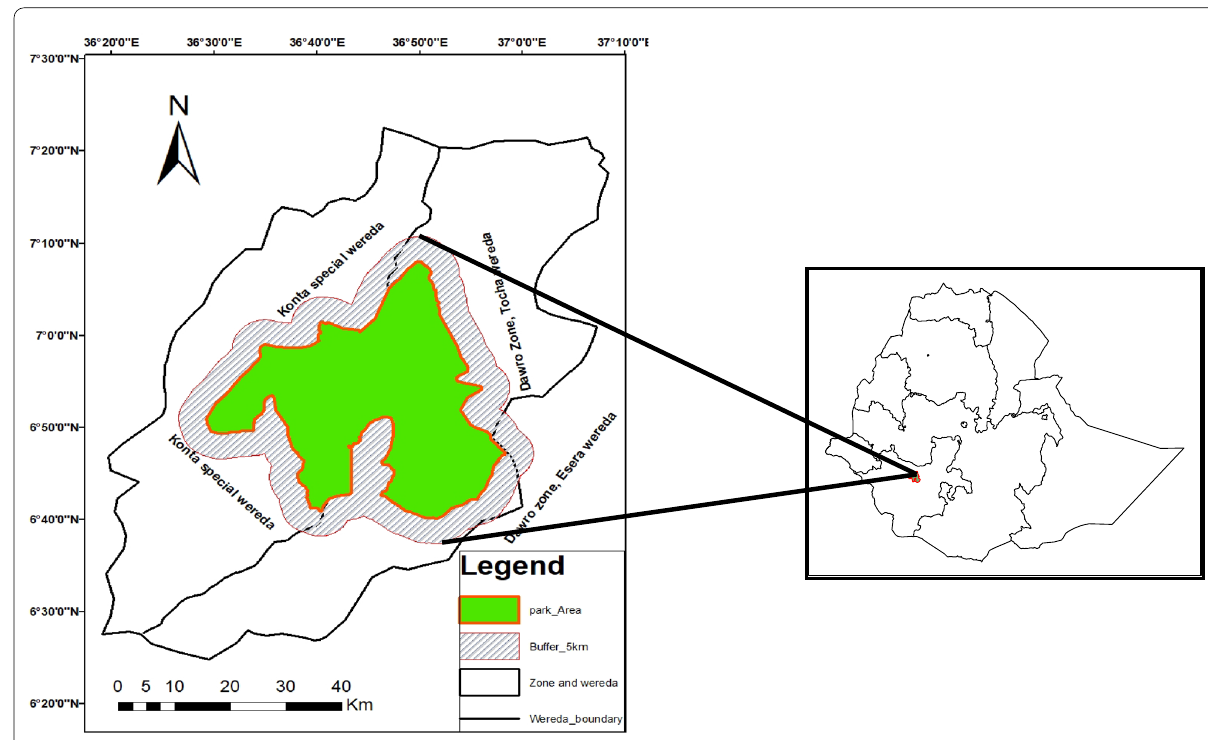
Fig. 1 The location of the study area, showing Chebera Churchura National Park (in green colour fill) and its buffer zone (in grey colour fill) [Coordinate System (GCS WGS